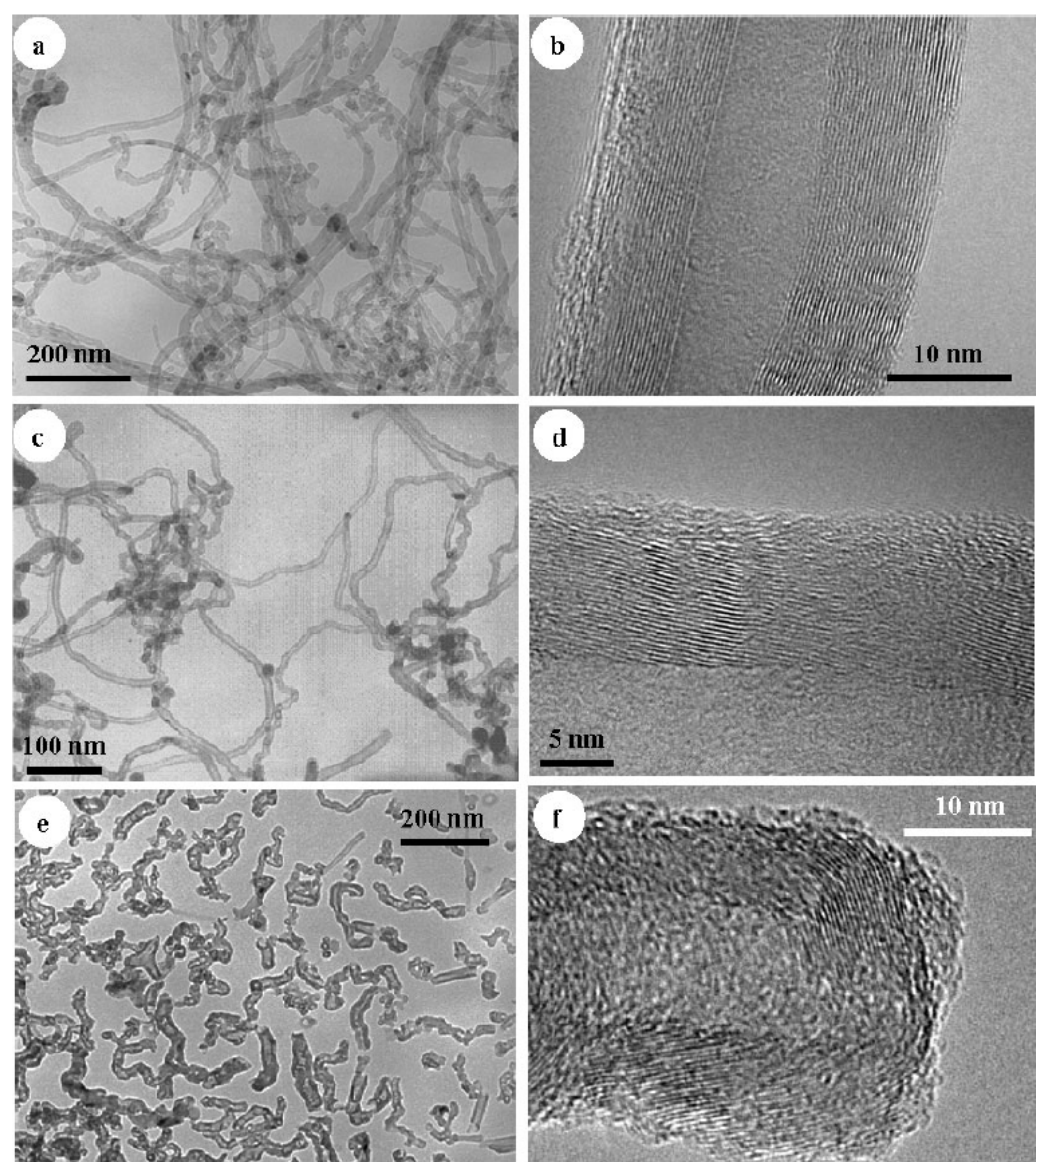
Figure 6. Transmission electron microscopy (TEM) and high-resolution TEM images of ( a,b ) very long; ( c,d ) long; and ( e,f ) short CNTs. (Reprinted with permission from [66]. Copyright (2007) by